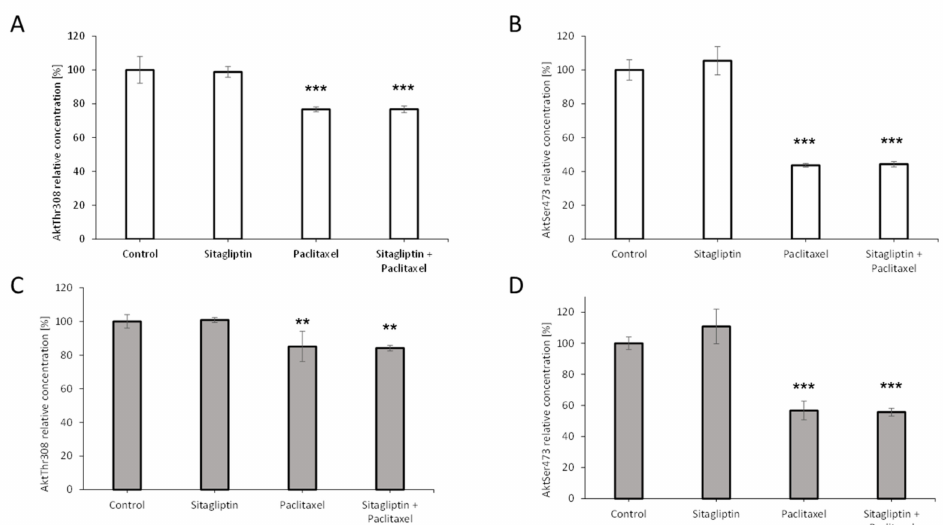
Figure 7. Phosphorylation of Akt kinase at Thr308 and Ser473 after sitagliptin (50 µ M), paclitaxel (10 nM), or sitagliptin (50 µ M) and paclitaxel (10 nM) treatment. Phosphorylation of Akt at Thr308 in SKOV-3 ( A ), phosphorylation of Akt at Ser473 in SKOV-3 ( B ), phosphorylation of Akt at Thr308 in OVCAR-3 ( C ), phosphorylation of Akt at Ser473 in OVCAR-3 ( D ), in cell lysates analyzed by PathScan Intracellular Signaling Array Kit after 24-h incubation with tested substances. Mean values ± SD are shown. n = 4 per group. ** p < 0.01, *** p < 0.001. Control vs. di ff erent conditions. One-way ANOVA followed with Dunnett’s post hoc